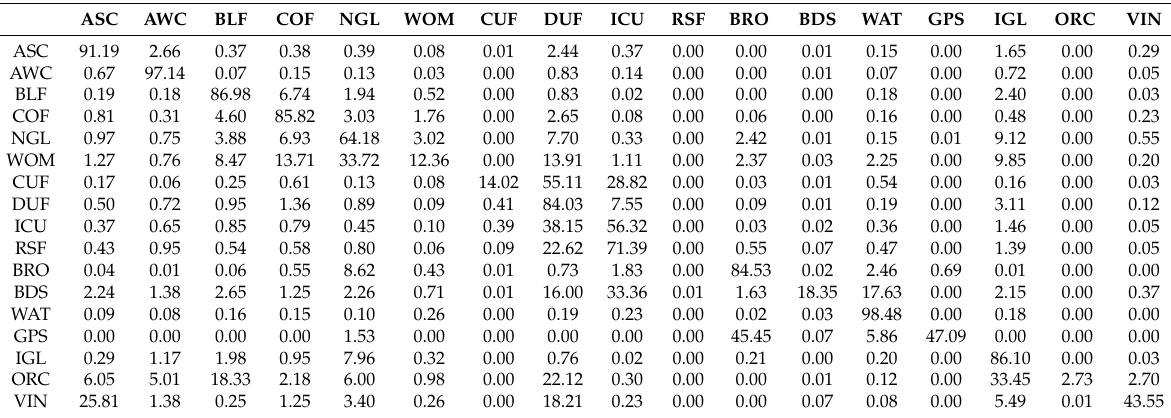
Table 2. Confusion matrix for the tile-based approach. Columns represent produced labels and rows represent the reference labels. Values are given in percentage of reference pixels (normalised per row). Diagonal values represnent the recall for each class.